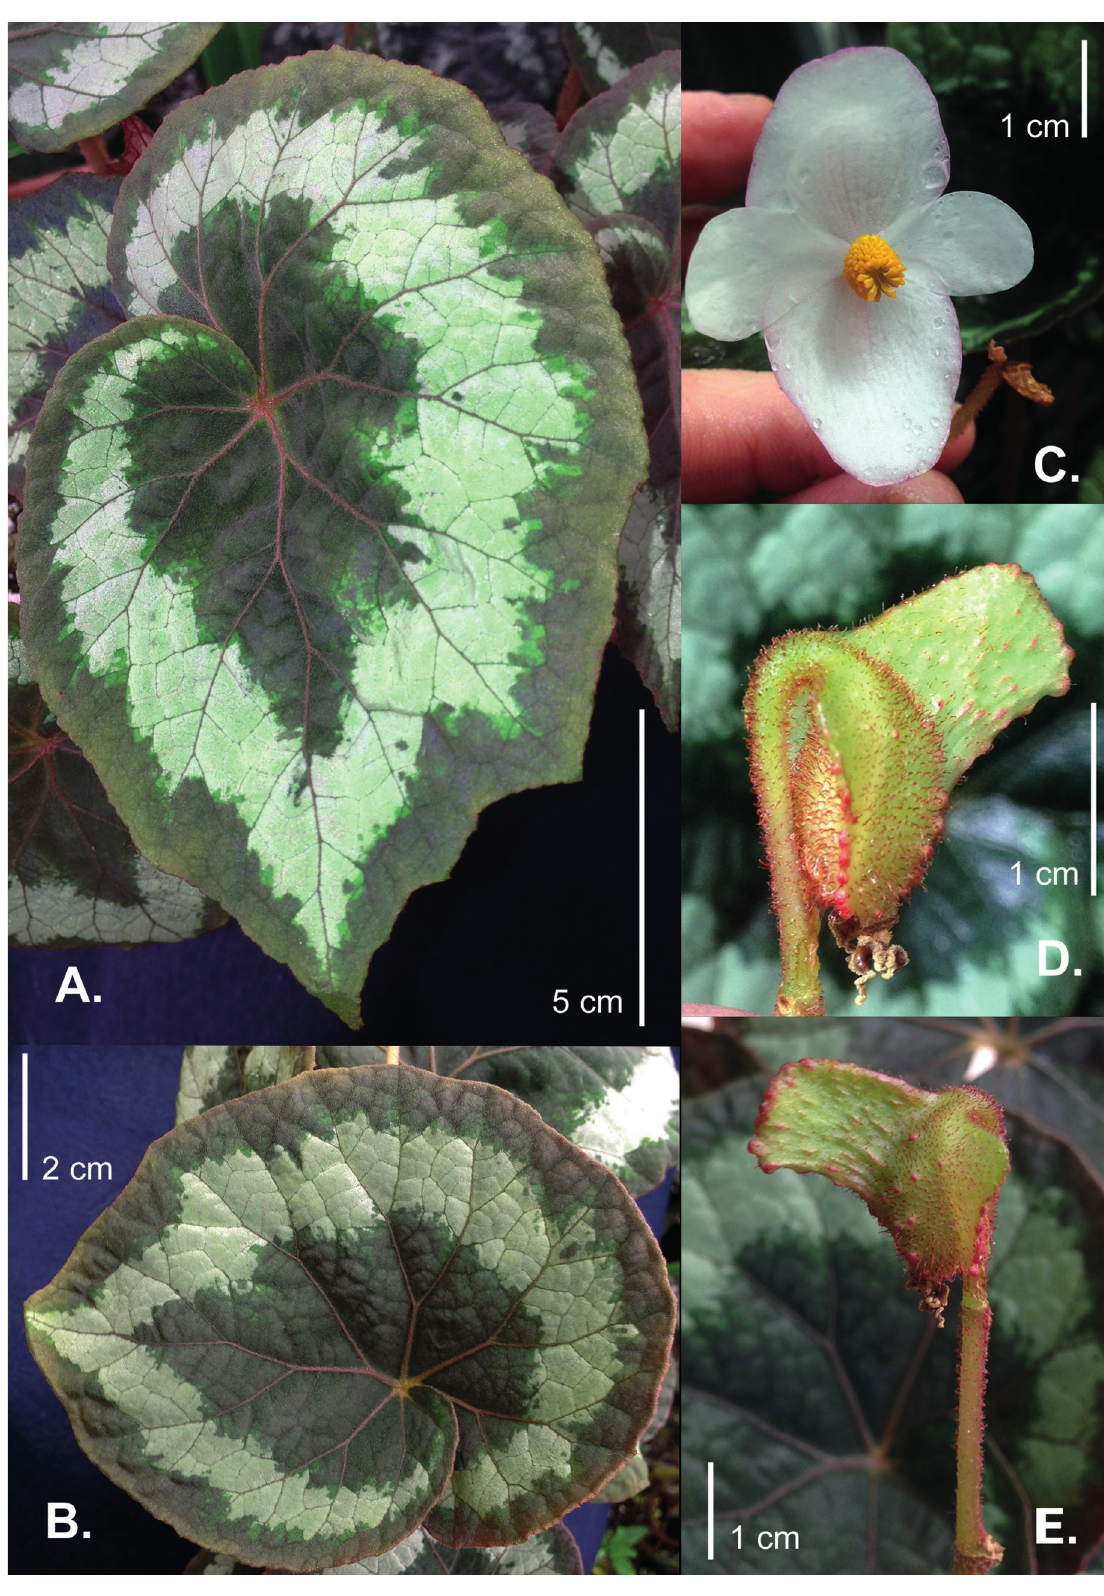
Fig. 11. Begonia annulata K.Koch. A–B . Leaf. C . Male flower. D–E . Fruit. Photographs courtesy of Darrin Norton of a plant in cultivation in a private